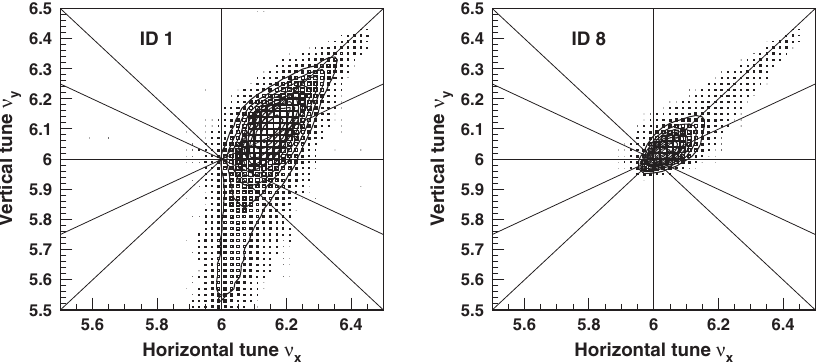
FIG. 11. Tune footprints at the end of injection calculated for the beam intensity of 539 kW without (ID 1) and with (ID 8) injection painting, where the solid lines show systematic resonances up to fourth order.